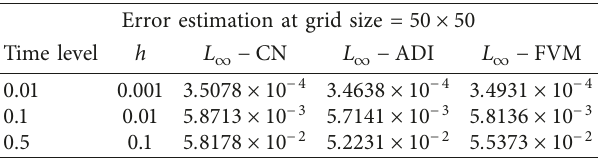
Table 6: Error norms of CN, ADI, and FVM at different times and space step size for unknown u ( p,q, t )